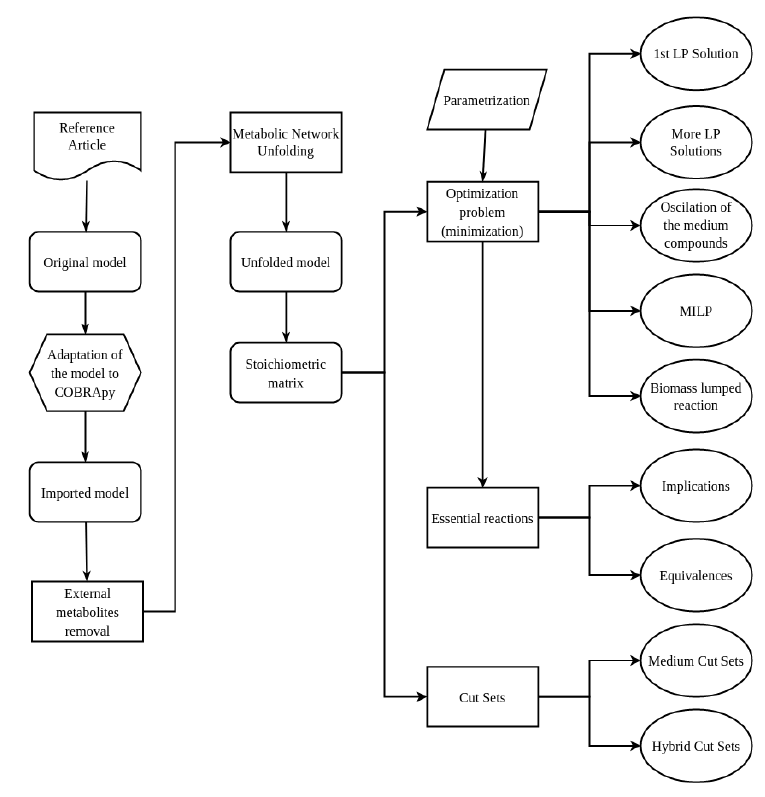
Figure 2. Pipeline for the analysis of the S. epidermidis RP62A